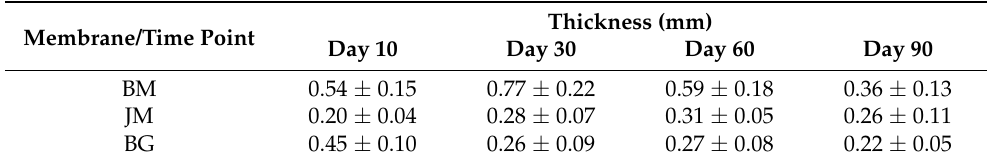
Table 9. Results of the Thickness Measurements.